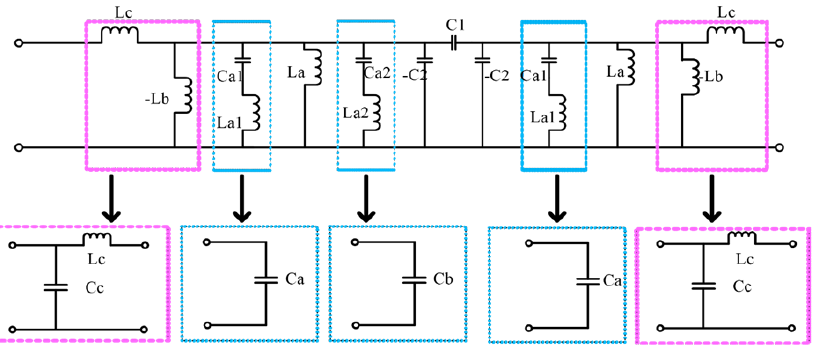
Figure 4. Equivalent circuit of the filter.